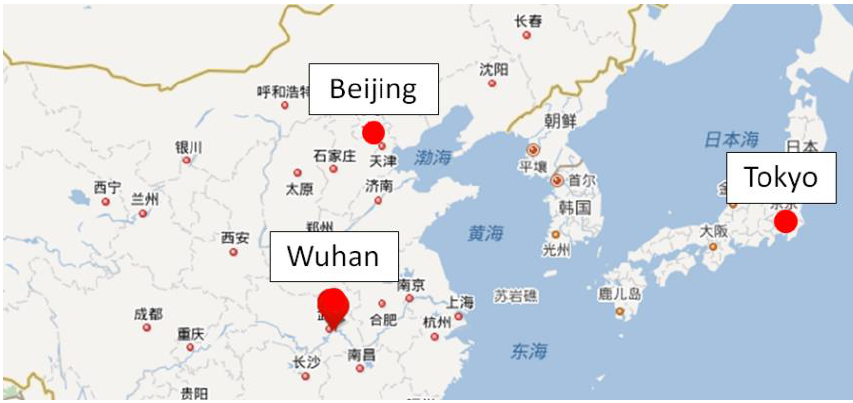
Figure 1. Location of Wuhan.